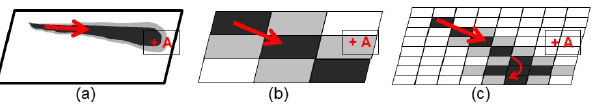
Fig. 4b encloses 9 km 2 , and the darker grey region encloses 49 km 2